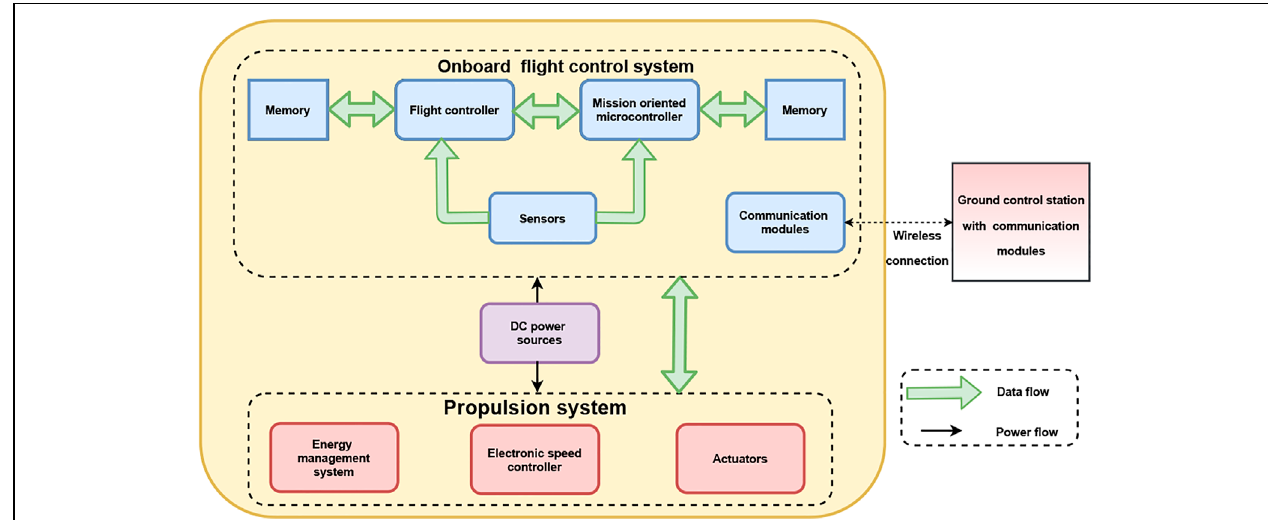
FIGURE 1 | Block diagram of Unmanned aerial